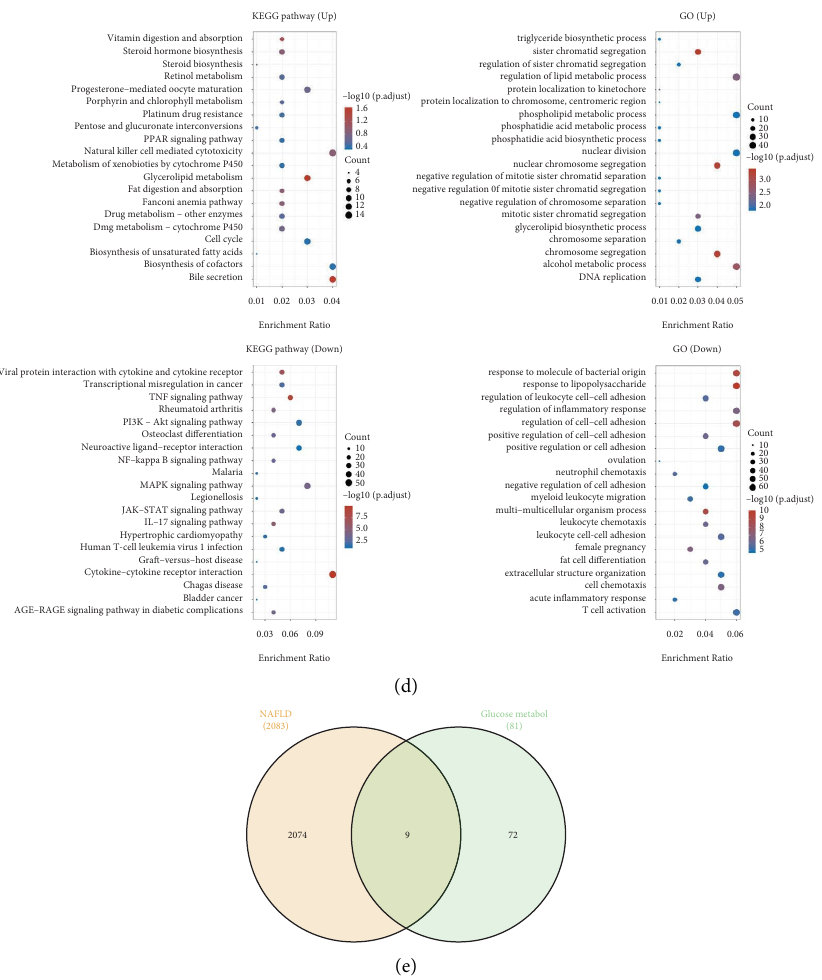
Figure 1: (a) Data normalization boxplots. (b) In this diferential gene volcano plot, the red dots represent signifcantly diferentially upregulated genes, and the blue dots represent signifcantly diferentially downregulated genes. (c) Te heatmap shows the diferential expression of genes across diferent tissues in terms of colors. (d) A functional enrichment analysis of diferentially expressed genes based on KEGG and GO pathways. (e) Te Venn diagram shows the genes that are associated with NAFLD and glucose